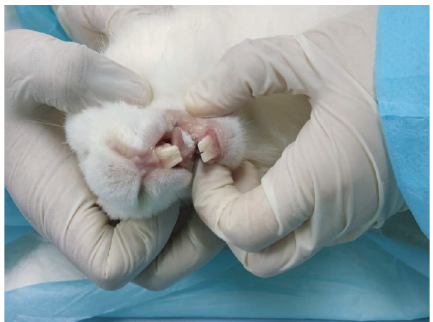
Figure 2: Drug administration process and fully disintegrated inside the rabbit mouth under the